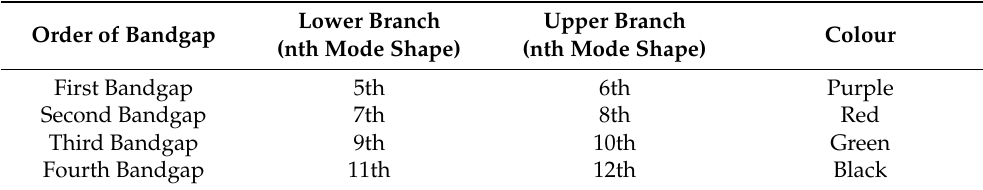
Table 2. Branch numbers related to various bandgaps in band diagrams of the modified unit cell with a cylindrical core of 𝐿 𝑅⁄ = 5 and the arm angle of 𝜃 = 0 .